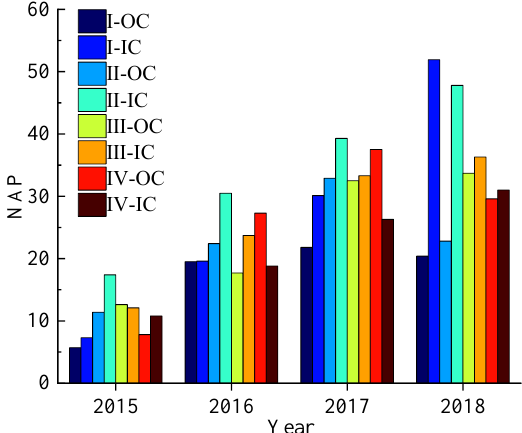
Figure 3. NAP value distribution.